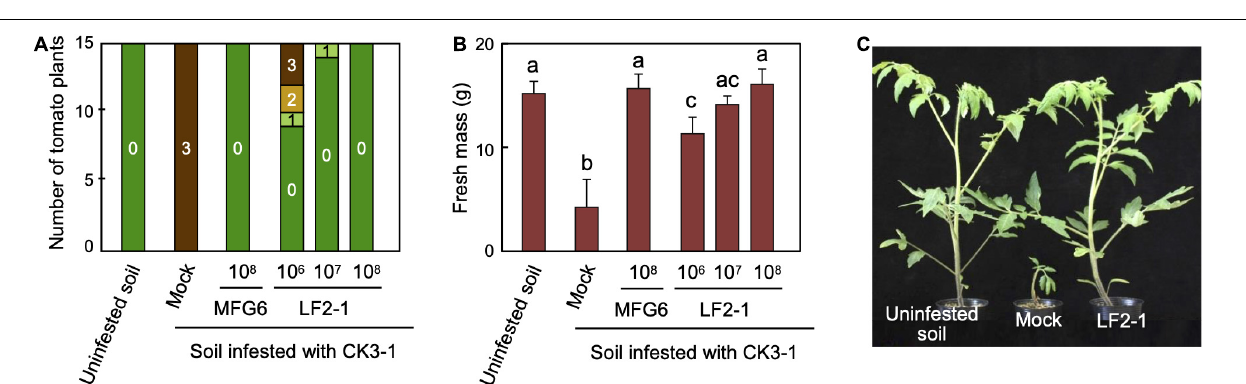
FIGURE 2 | Biocontrol activity of pathogenicity gene mutants of Fusarium oxysporum f. sp. lycopersici against the parental strain. Roots of tomato seedlings were dipped in conidial suspensions (1 × 10 6 , 10 7 or 10 8 conidia/mL) of (cid:49) FOW2 strain LF2-1 of F. oxysporum f. sp. lycopersici or nonpathogenic strain MFG6. The seedlings were planted in soil infested with parental wild-type strain CK3-1 (1 × 10 5 conidia/g soil). Control seedlings were immersed in water and planted in uninfested or infested soil (Mock). (A) Symptoms were scored 21 dpi as 0, no symptoms; 1, yellowing; 2, wilted; 3, dead. (B) Fresh mass of aboveground parts of tomato seedlings ( n = 15) at 21 dpi. Data represent averages and standard errors based on 15 seedlings. Columns with different letters indicate that means differed significantly at P ≤ 0.01 in the Tukey–Kramer multiple range test. (C) Plants at 21